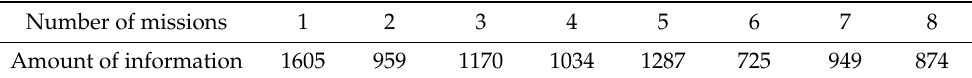
Table 2. Mission information data.